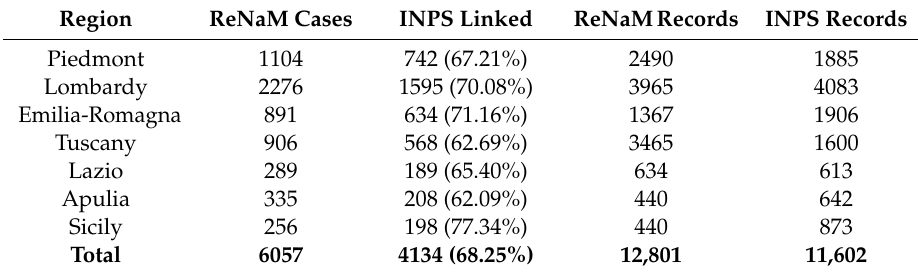
Table 1. The number of malignant mesothelioma (MM) cases included in The Italian National Mesothelioma Registry (ReNaM) and the number of subjects linked ( n , %) to the Social Security Institute (INPS) database, and the corresponding number of occupational records, by region.